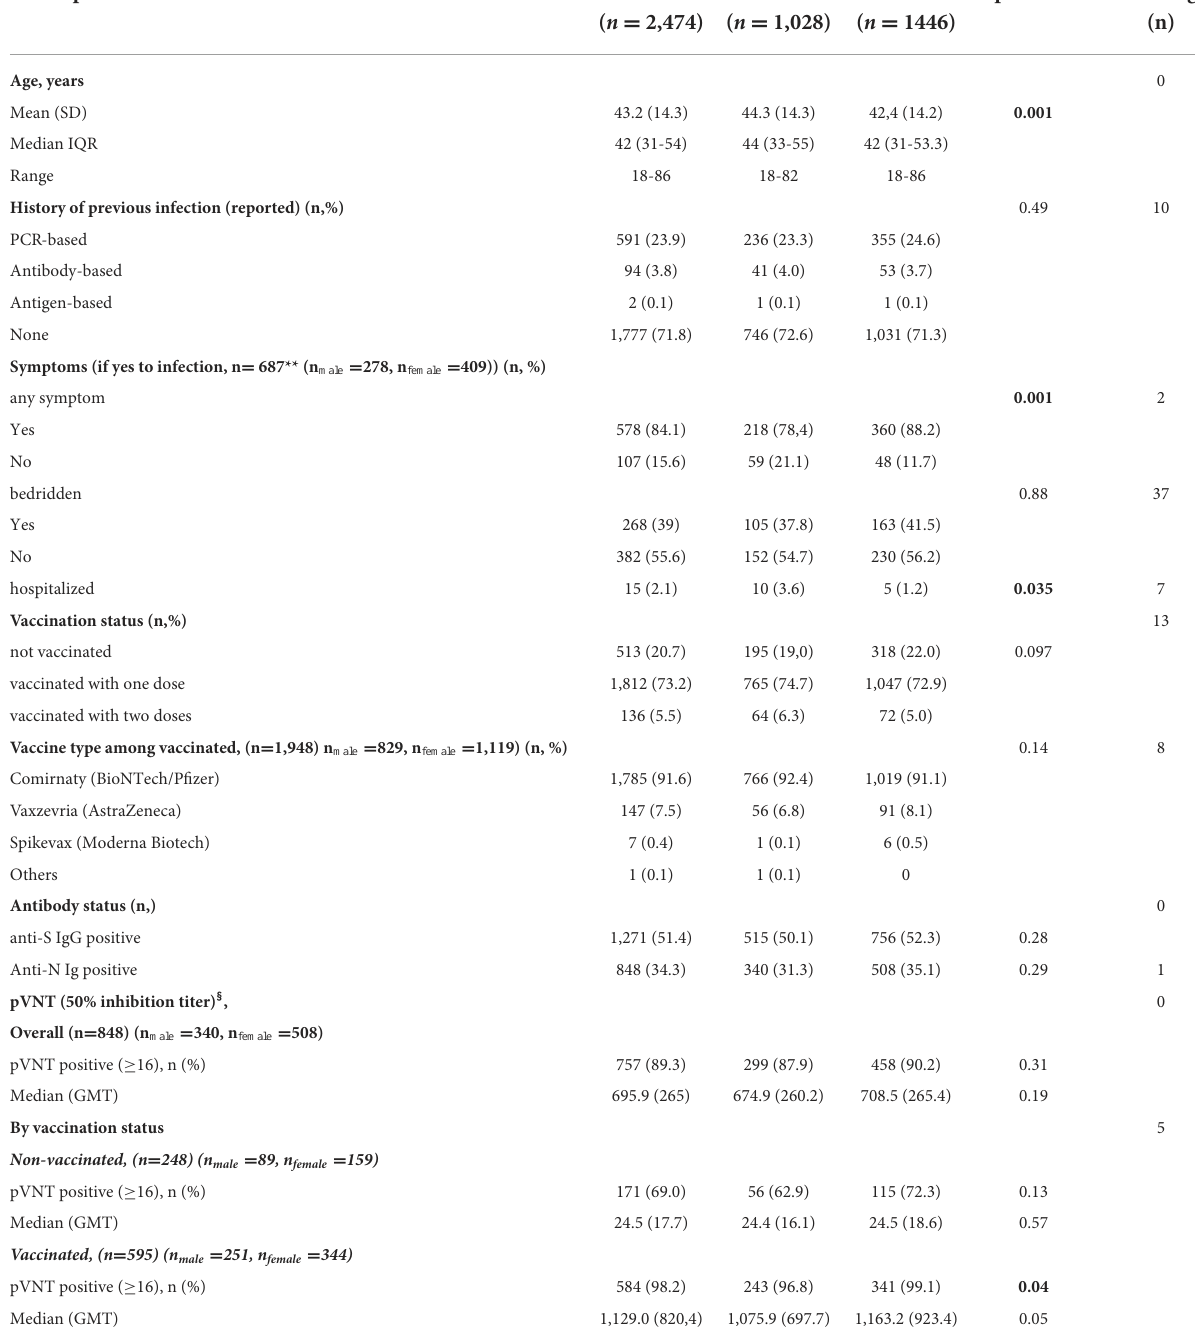
TABLE 1 Baseline characteristics of study participants (n =